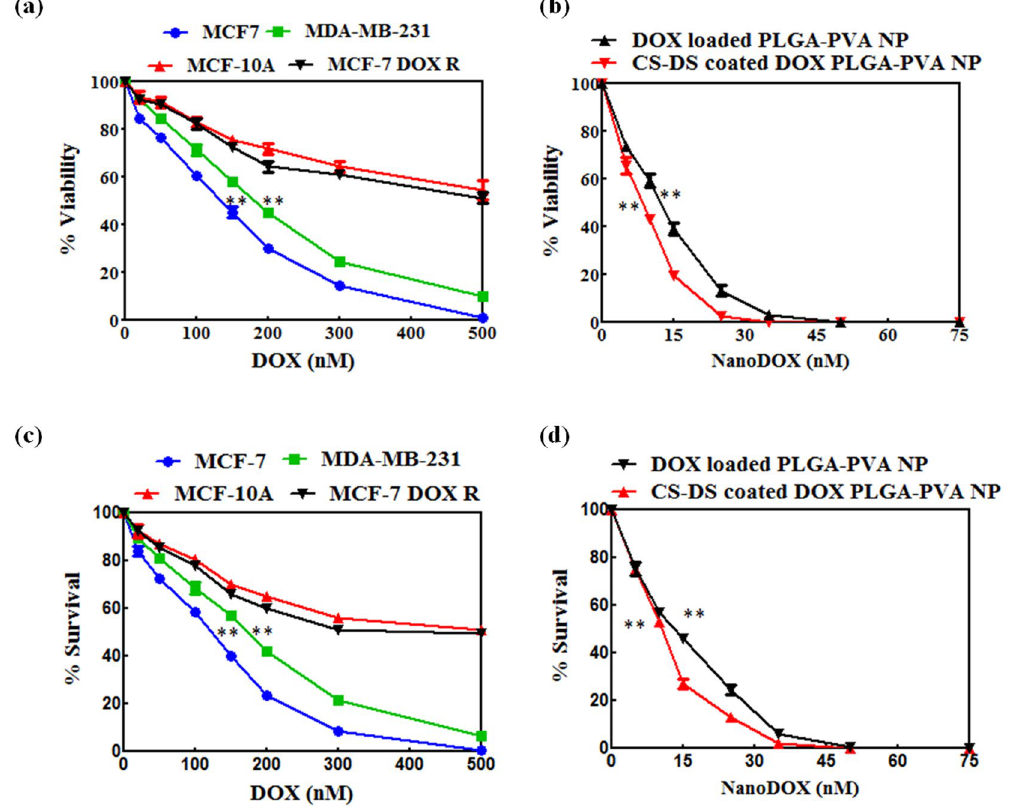
MCF-7 DOX-R cells. ( C ) Clonogenic cell survival assay of DOX treated different breast cancer cells (MCF-7 and MDA-MB-231), normal breast epithelial cells (MCF-10A) and MCF-7- DOX-R cells. ( D ) Clonogenic